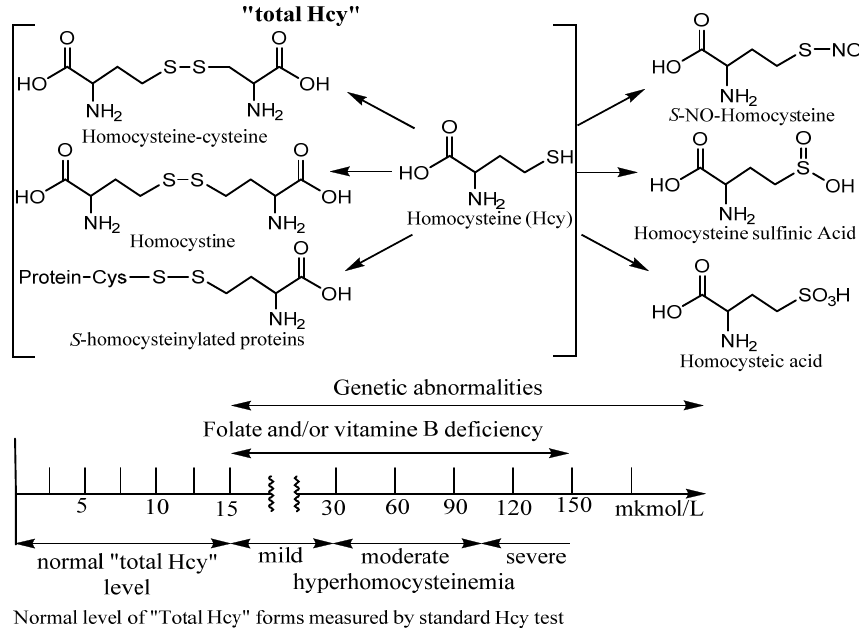
Figure 2. Examples of Homocysteine products of metabolism. “Total homocysteine” level in plasma in healthy patients and under vitamin deficiency and genetic disorders. Many Hcy metabolism products as homocysteic acid, homocysteine sulfinic acid, homocysteine, and S -homocysteinylated proteins are beyond this